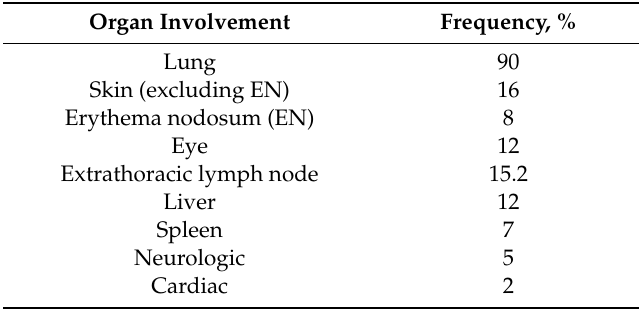
Table 1. Overall frequency of organ involvement at the time of diagnosis (patients could have more than one organ involved) adapted from Baughman RP et al., 2001. [4].